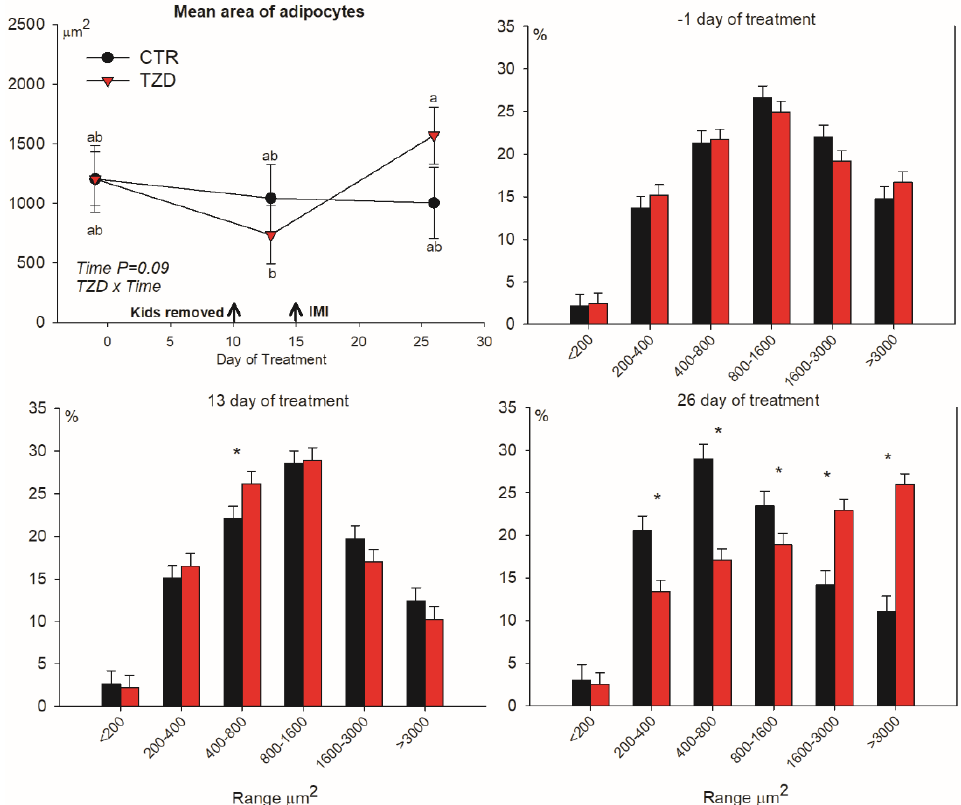
Figure 4. Median area of adipocytes and frequency (%) in each specific range in area of adipocytes in subcutaneous tissue collected from the tail-head of goats receiving daily intra-jugular injection of 2,4-thiazolidinedione (TZD) or saline (CTR). Arrows indicate removal of kids and time of intramammary infusion of Strep. uberis in the right half of the mammary gland (IMI). Letters in the graph (a, b) denote significant effects of time and interactions (Z × T). Asterisks (*) denote differences ( p ≤ 0.05) between treatments in the same range of area of adipocytes. Error bars denote SEM